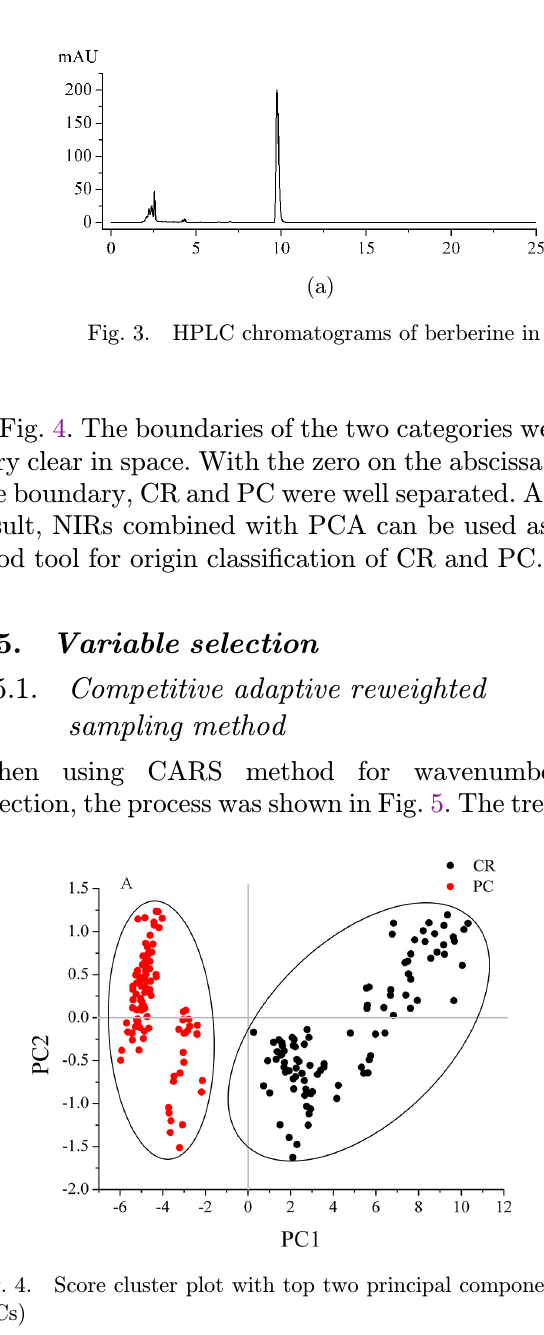
Fig. 2. HPLC chromatograms of berberine in CR. (a) Extract of CR sample and (b) Standard solution.